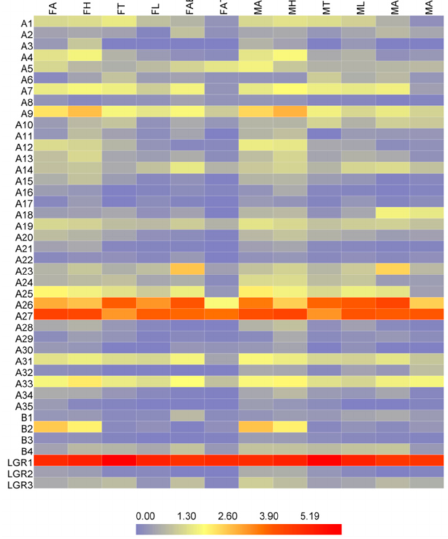
Figure 6. Expression profiles of neuropeptide receptors in various tissues of D. citri based on FPKM values. The mRNA levels, as represented by log2 (FPKM + 1) values, are shown in the heat map with colors ranging from blue (low expression) to red (high expression). MA, male antenna; MH, male head; MT, male thorax; ML, male leg; MAB, male abdomen; MAT, male abdomen terminal; FA, female antenna; FH, female head; FT, female thorax; FL, female leg; FAB, female abdomen; FAT, female abdomen terminal.